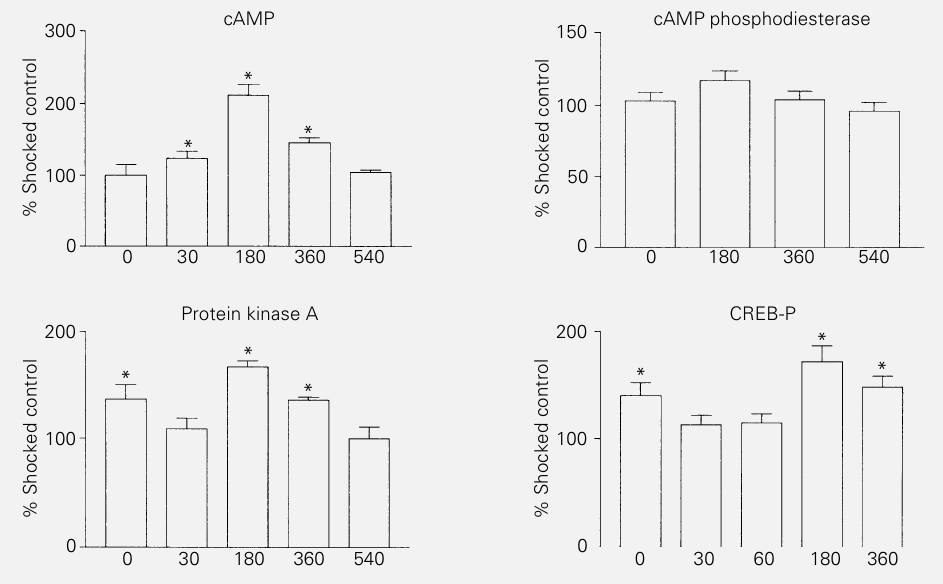
Figure 2 - Top left panel , Mean – SEM cAMP levels in extracts of rat hippocampus measured with a specific antibody (Sigma). There was a peak at 180 min, a slight decrease at 360 min, and a return to control values at 540 min. *P<0.02 by Newman-Keuls after ANOVA; N = 5 independent experiments done in duplicate. Top right panel , Mean – SEM cAMP phosphodiesterase activity (PDE) measured by the hydrolysis of [ 3 H]cAMP. No changes were detected at any time after training; N = 6 independent experiments done in duplicate. Bottom left panel , Mean – SEM levels of PKA activity measured by the phosphorylation of kemptide. There was a peak immediately after training, followed by a return to control values, and a second, higher peak at 180 and 360 min. *P<0.01 by Newman-Keuls after ANOVA; N = 5 independent experiments done in triplicate. Bottom right panel , Mean – SEM of CREB-P immunoreactivity obtained by densitometric analysis of specific immune complexes of CREB-P with a specific antibody (provided by Prof. D.D. Ginty) visualized in histological sections with an avidin biotin detection system. As with PKA, there were two peaks of CREB-P: the first 0 min after training, and the second at 180 min. *P<0.01 by Newman-Keuls after ANOVA; N = 5 independent experiments done